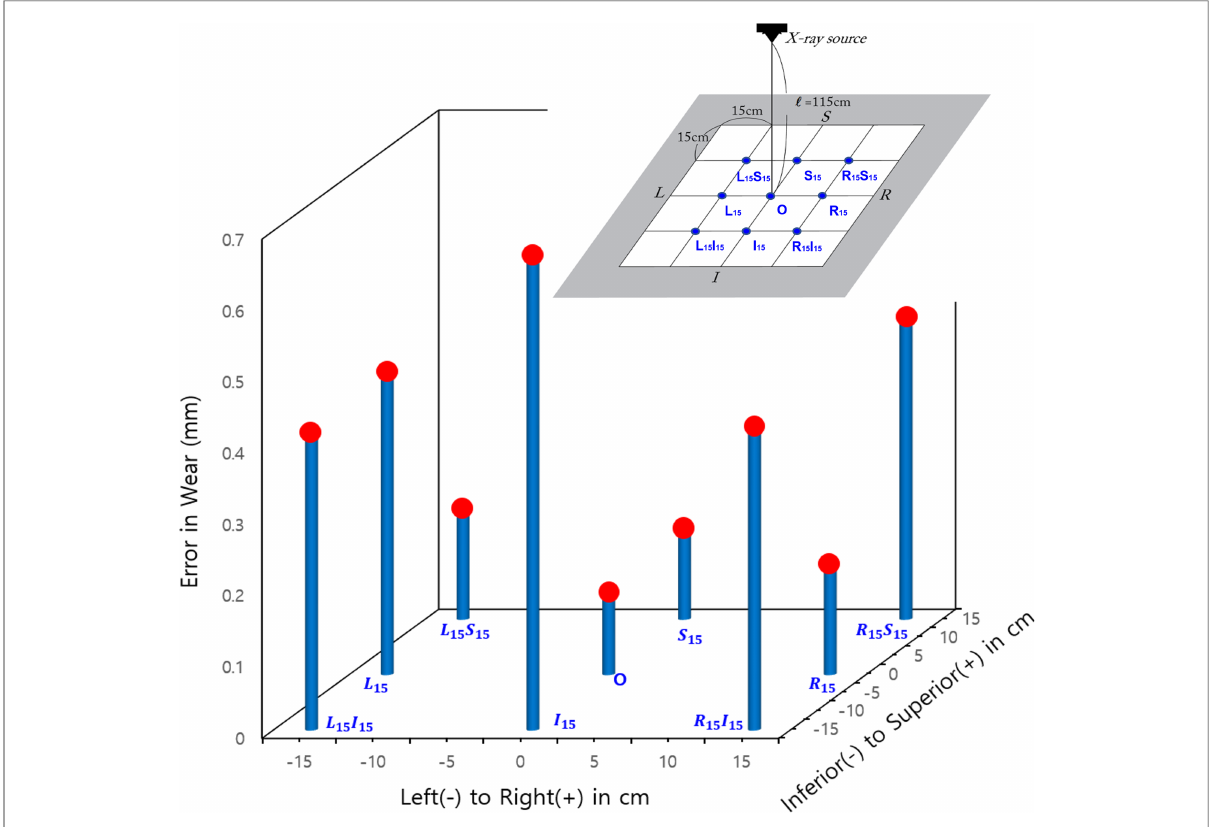
FIGURE 8 The error (in absolute values) in the wear of the femoral head ’ s spatial eccentricity modes in the original